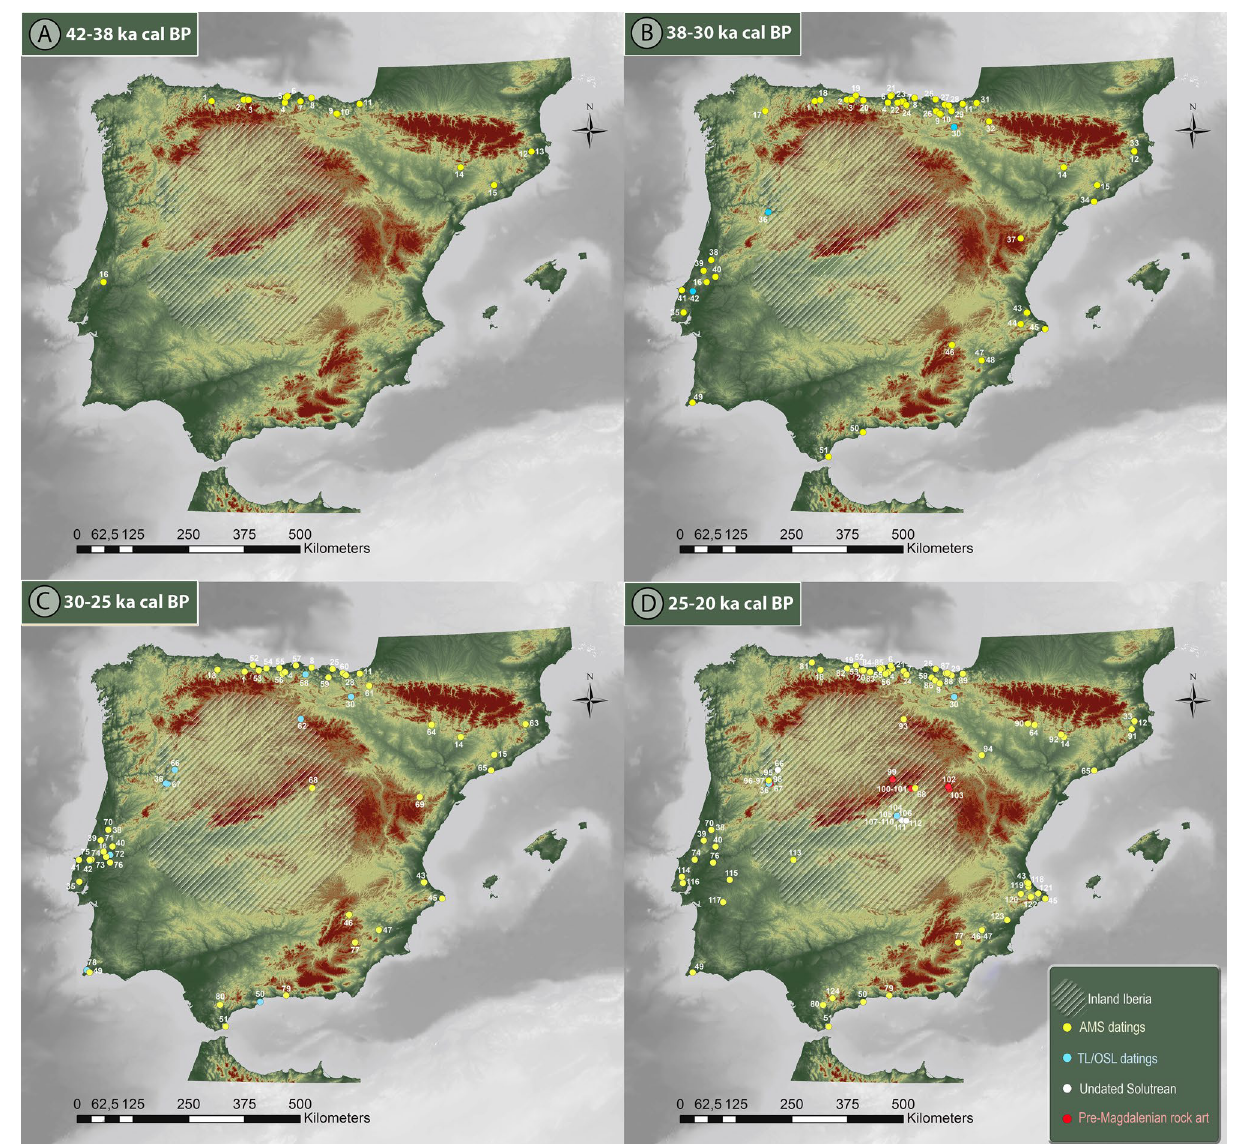
Figure 1. Process of peopling of the Iberian Peninsula by modern humans during the Upper Paleolithic. A: 42 – 38 ka cal BP, B: 38 – 30 ka cal BP, C: 30–25 ka cal BP, D: 25–20 ka cal BP (see Supplementary Text S3 for discussion and Supplementary Datasets 1–4 for full data). Maps generated with ArcGIS (ArcMap 10.3.1.) (https:// www. arcgis. com/ index. html) using ASTER Global Digital Elevation Model V0032019, distributed by NASA EOSDIS Land Processes DAAC,